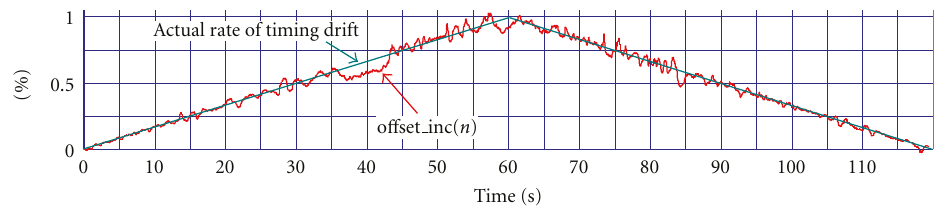
Figure 6: Actual and estimated rates of timing drift for Test Case 3.